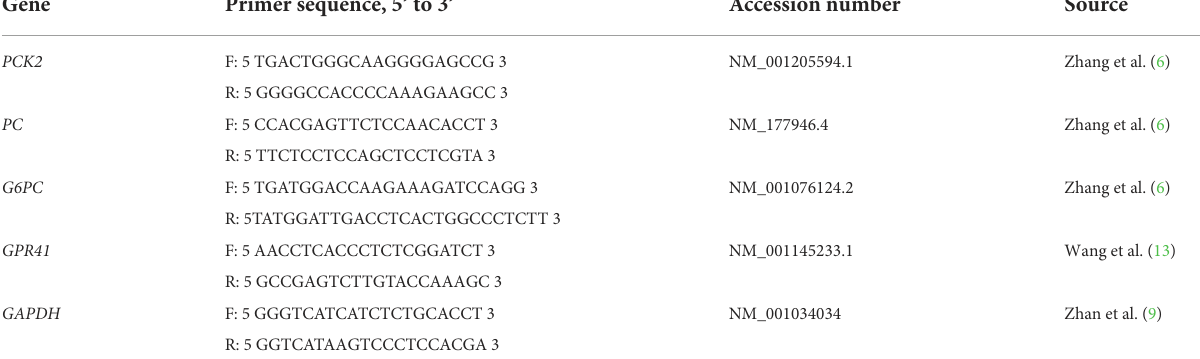
TABLE 1 Primers for real-time PCR analysis.